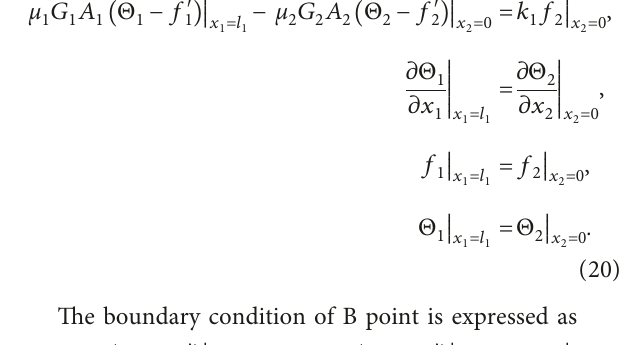
Figure 3: The model of rotor damage-instability caused by aerodynamic excitation